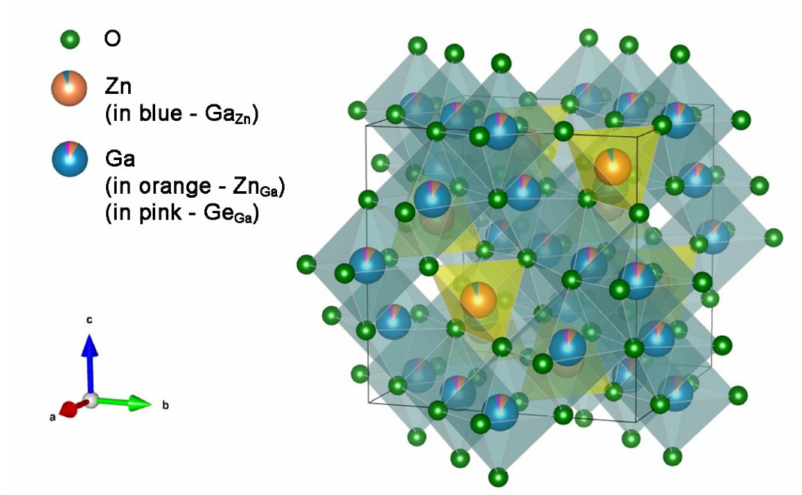
Figure 1. Structural model of ZGO:Cr and ZGGO:Cr. When x = 0.1 Ge replaces Ga atoms, as represented by the pink portion on Ga atoms. The model was obtained using the free software VESTA and the data from Allix et al.